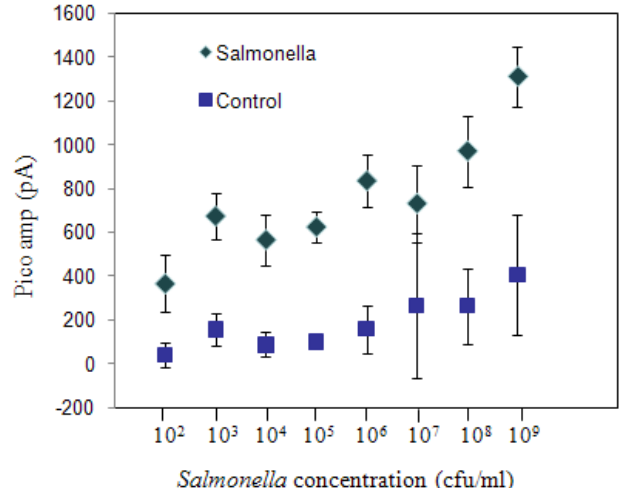
Figure 1. Sensitivity of the immunosensor using serial dilutions of S . Enteritidis cells suspended in phosphate buffered saline (PBS). Controls are devoid of